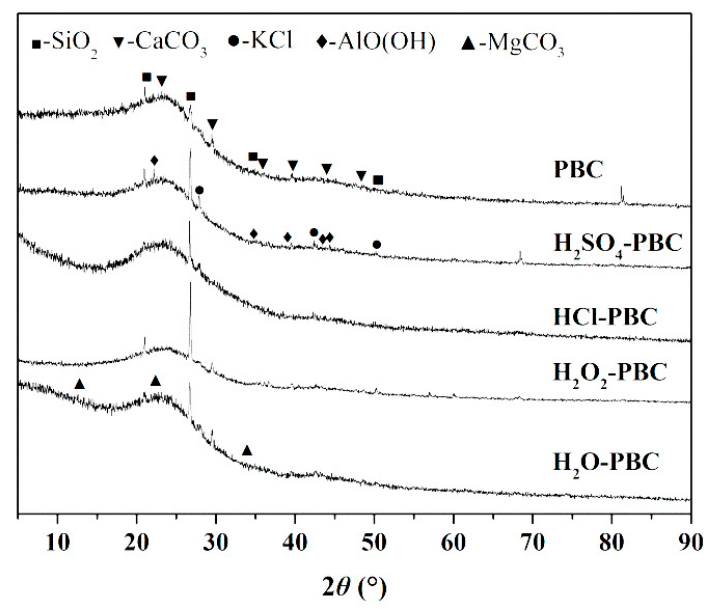
ff erent biochar samples.